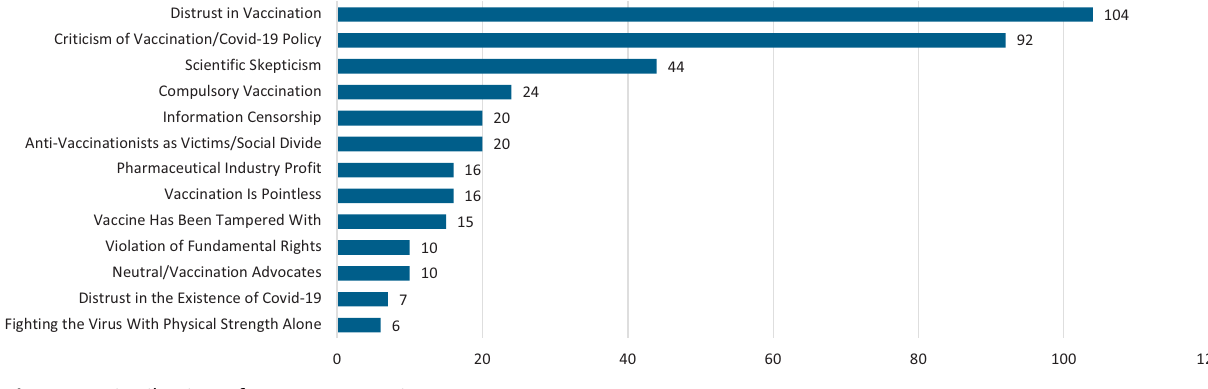
Figure 3. Distribution of German narratives.